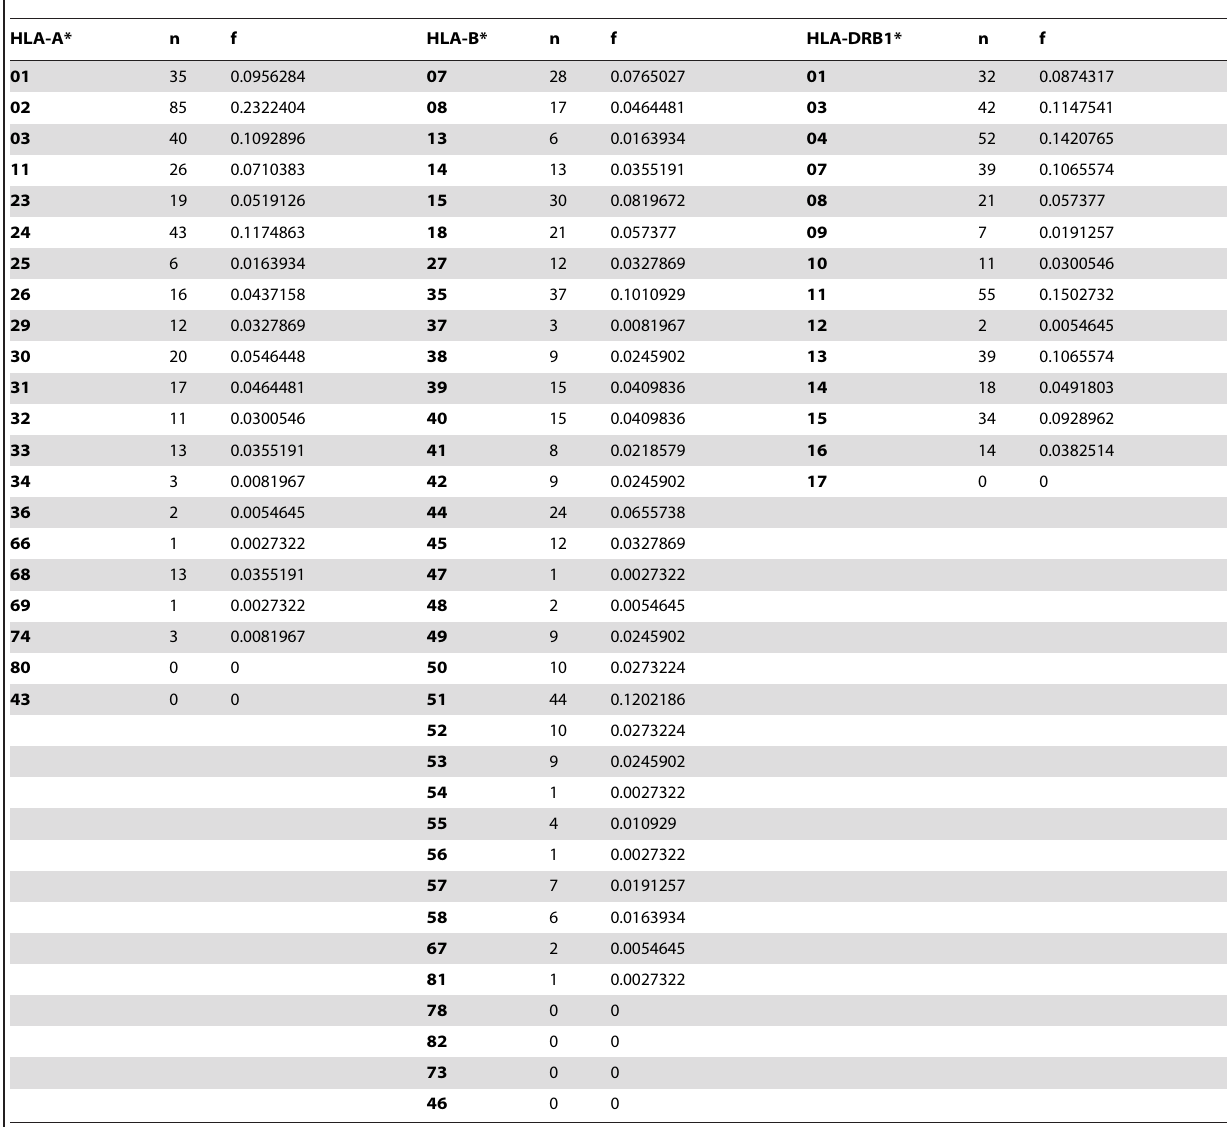
Table 3. Frequencies of HLA-A, -B and -DRB1 allele groups in CKD patients in southern Brazil.